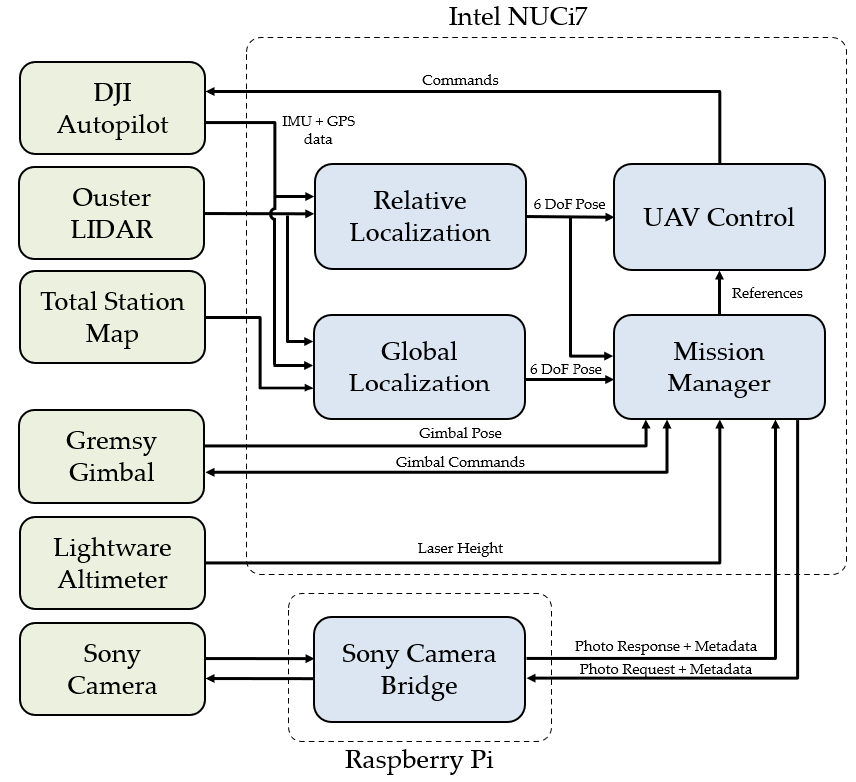
Figure 4. AERO-CAM general software architecture.